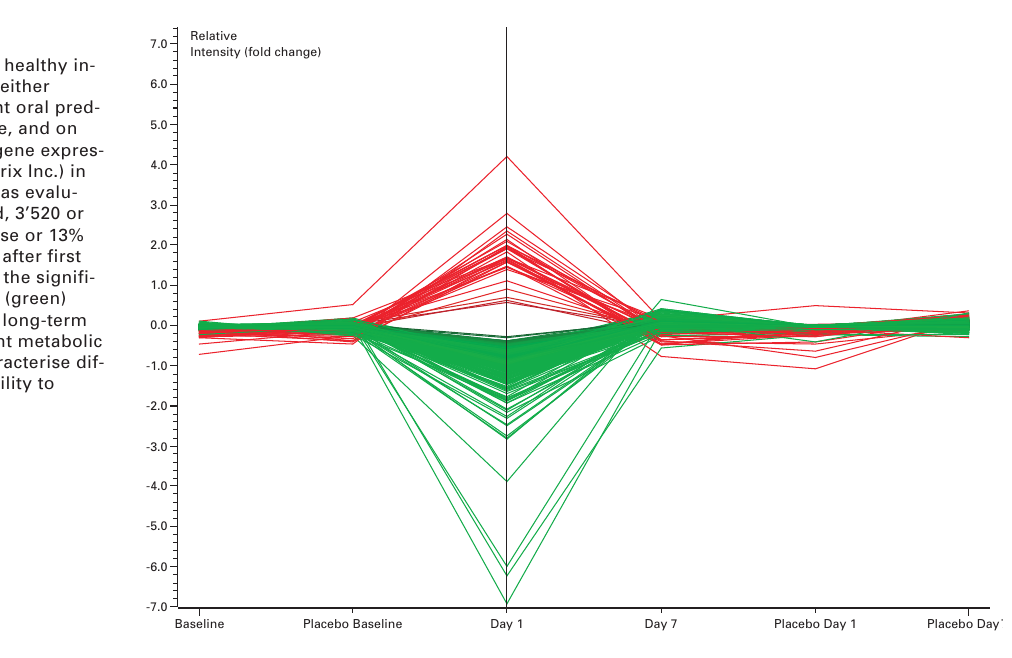
7.0 Relative Intensity (fold change)